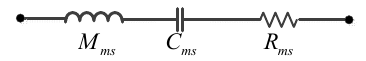
Figure 5. Equivalent circuit of mechanical domain.